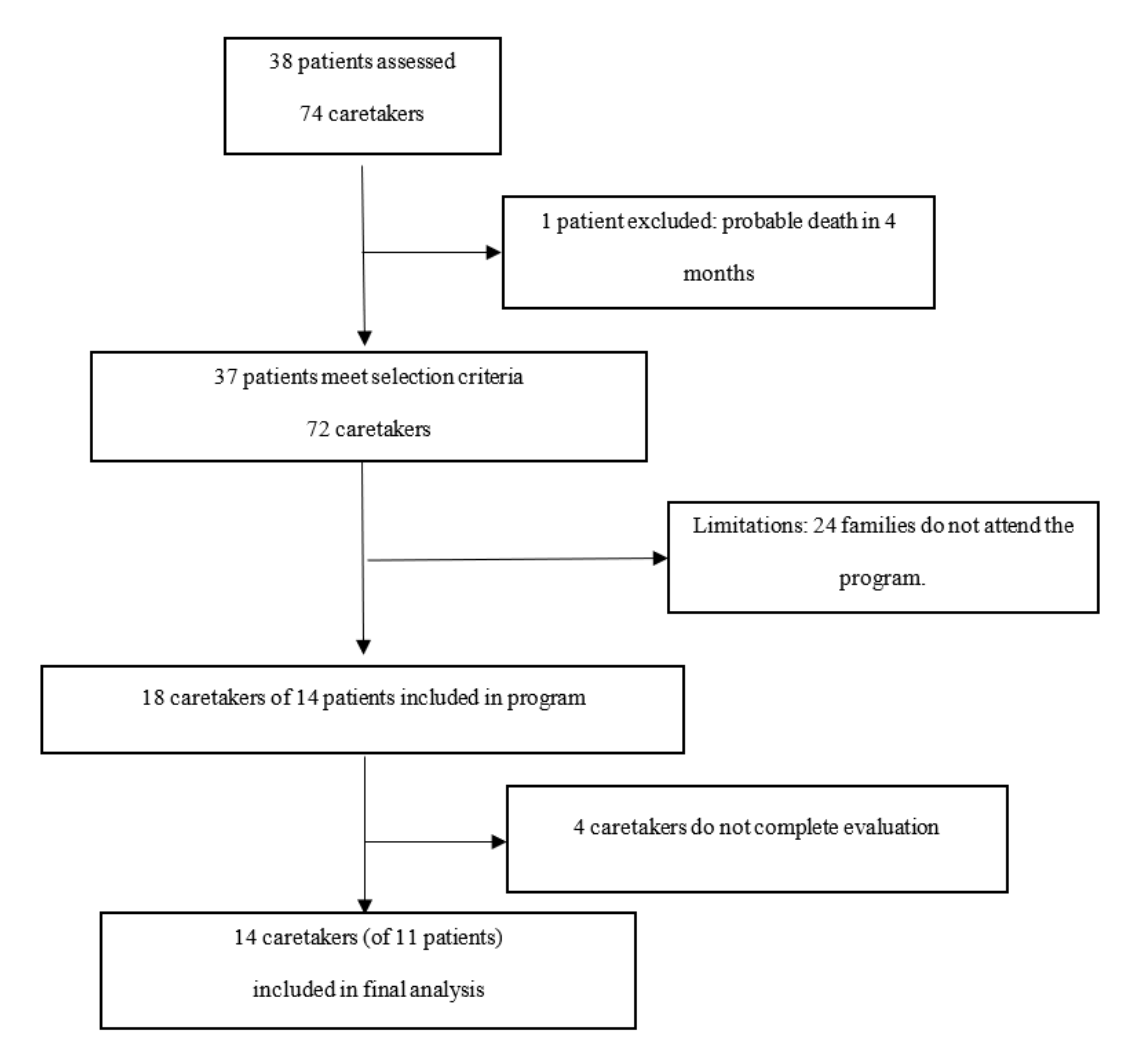
Figure 2. Study Flow chart. Diagram of assessed patients and caretakers participating in the program